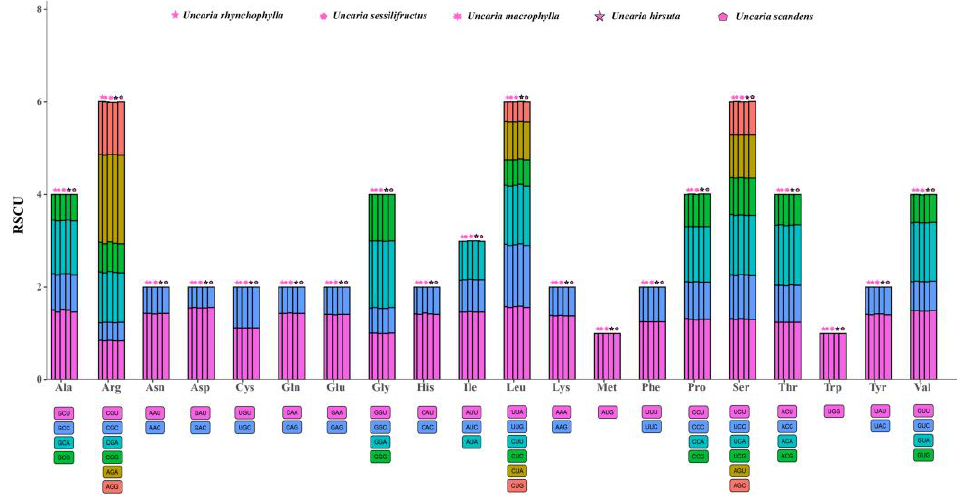
Figure 4. RSCU value comparison plots for amino acids in the protein-coding regions of five Uncaria species. The codon colors and the histogram colors match each other, their heights represent the RSCU value. The histogram from left to right is U. rhynchophylla, U. sessilifructus, U. macrophylla, U. hirsuta, and U. scandens.